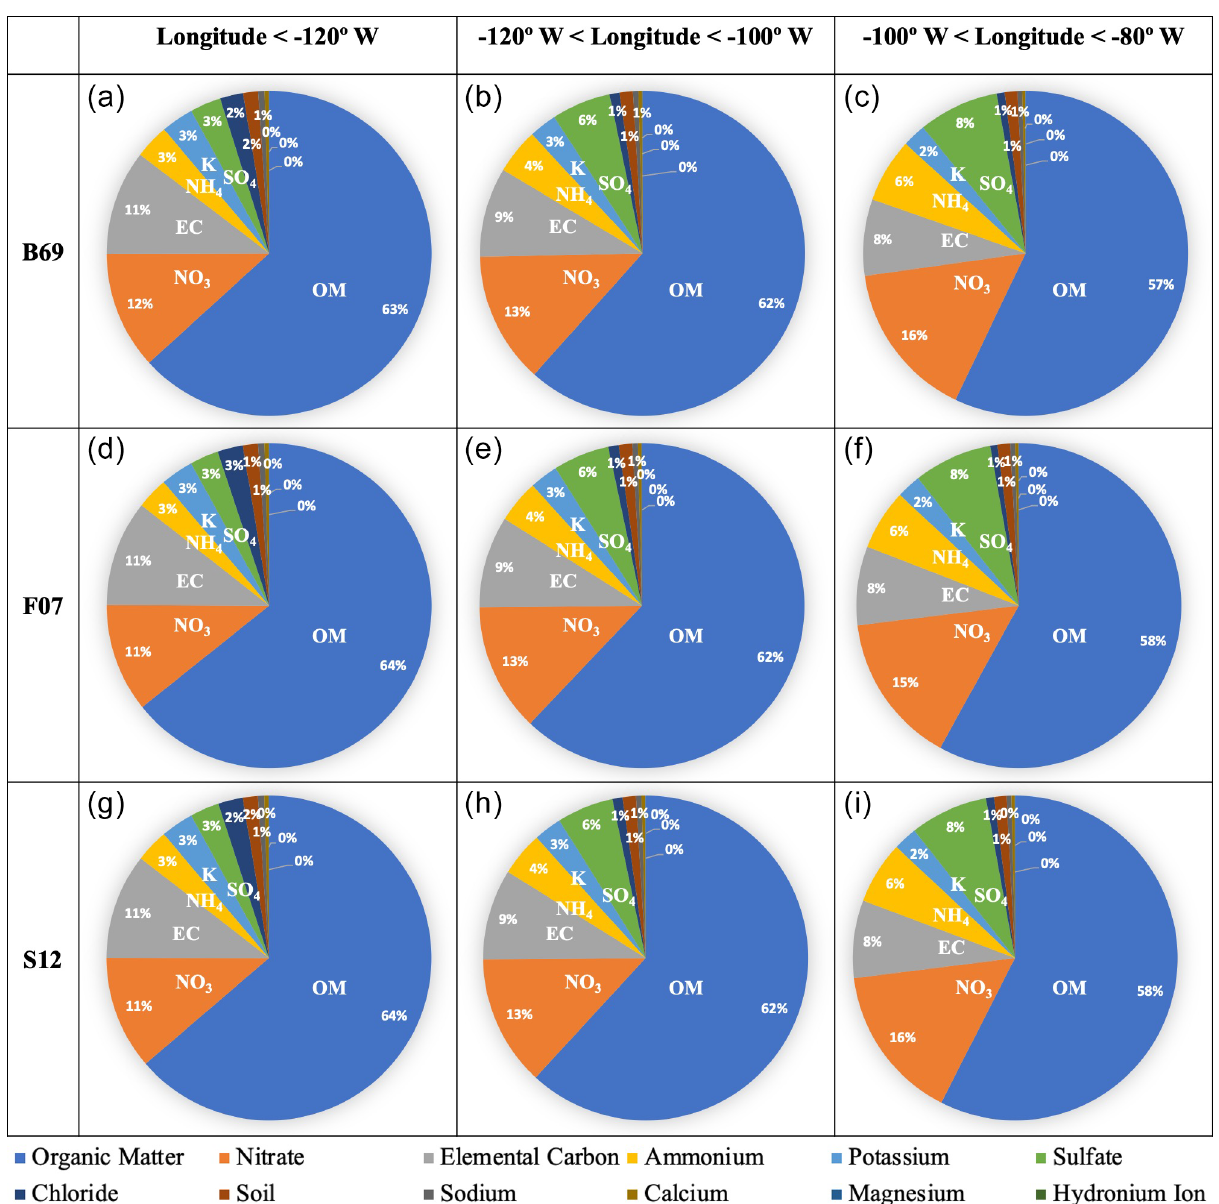
Figure 6. The simulated PM 2 . 5 chemical components (%) with the B69, F07, and S12 plume rise schemes in three different regions, i.e., to the west of 120 ◦ W (a, d, g) , between 120 and 100 ◦ W (b, e, h) , and between 100 and 80 ◦ W (c, f, i) . The data are integrated over all vertical layers and averaged during the analysis period. The top six components are labeled in each